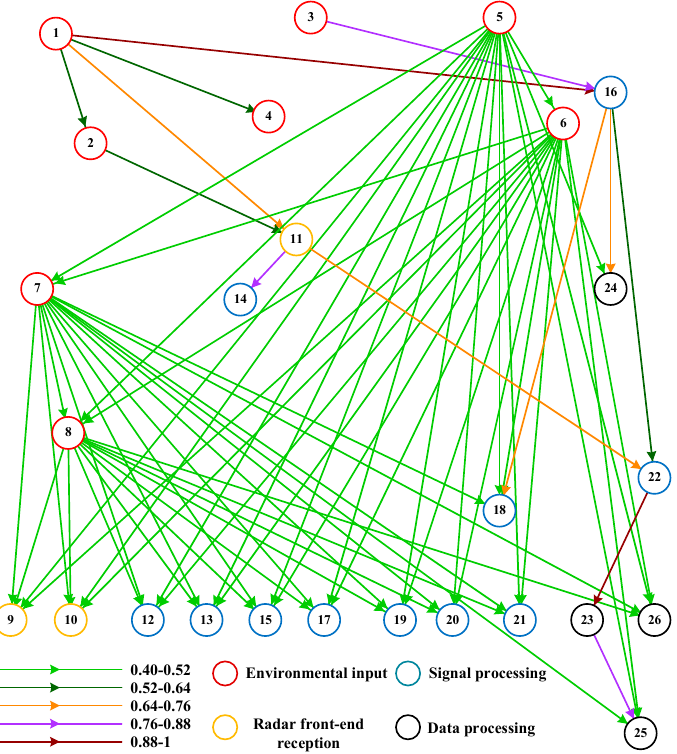
Figure 10. The BN model of radar effect mechanism.